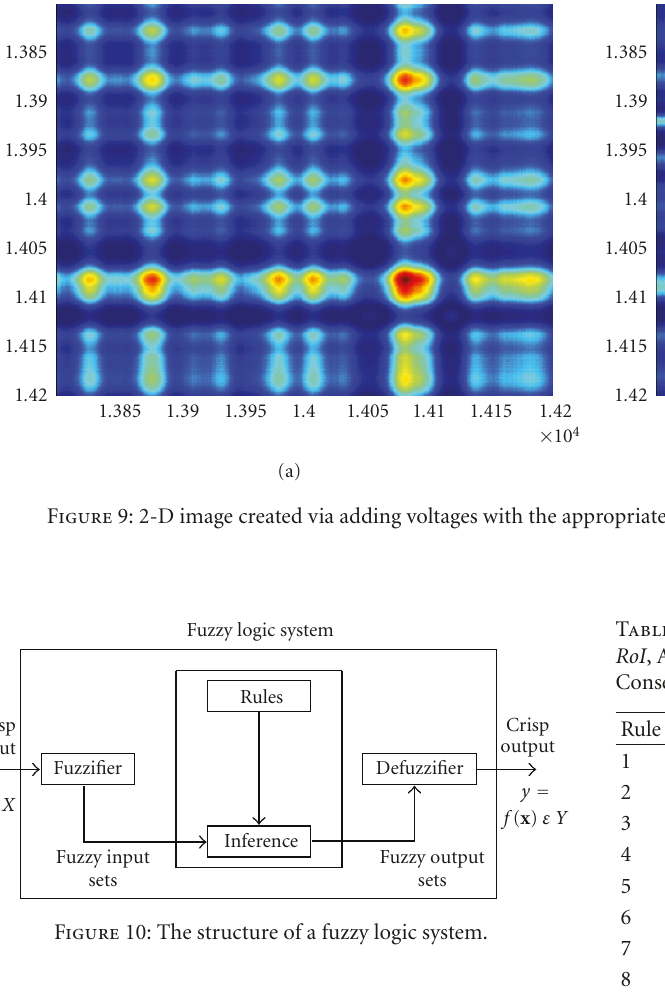
Figure 10: The structure of a fuzzy logic system.